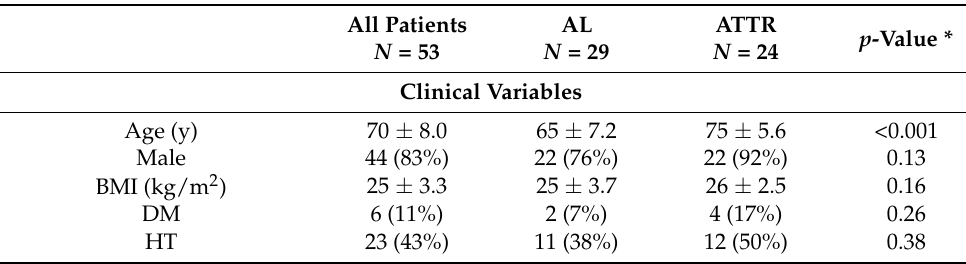
Table 1. The baseline characteristics for all immunoglobulin light chain and transthyretin cardiac amyloidosis patients.